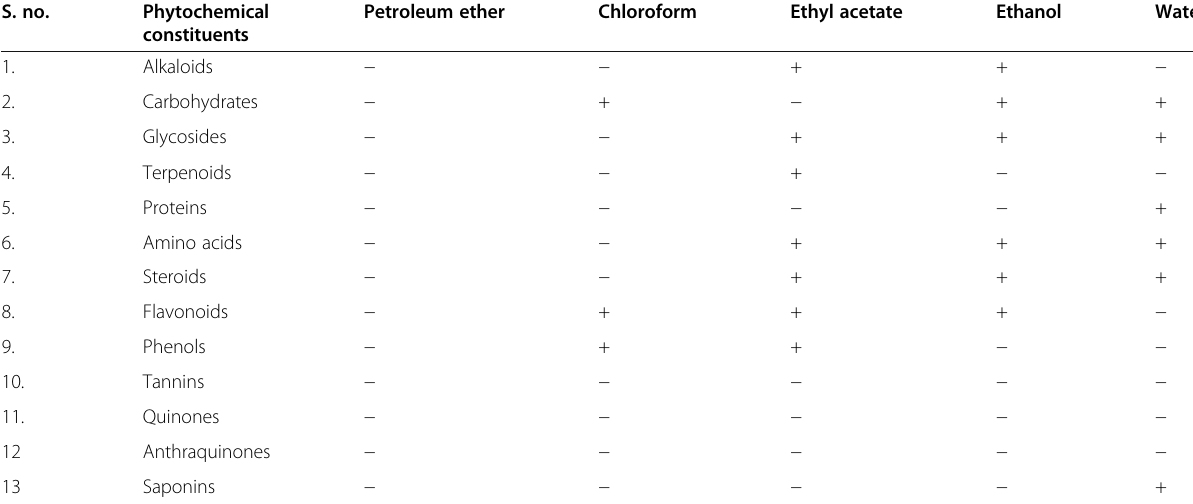
Table 2 Phytochemical analysis of Clerodendrum thomsoniae Balf S. no.